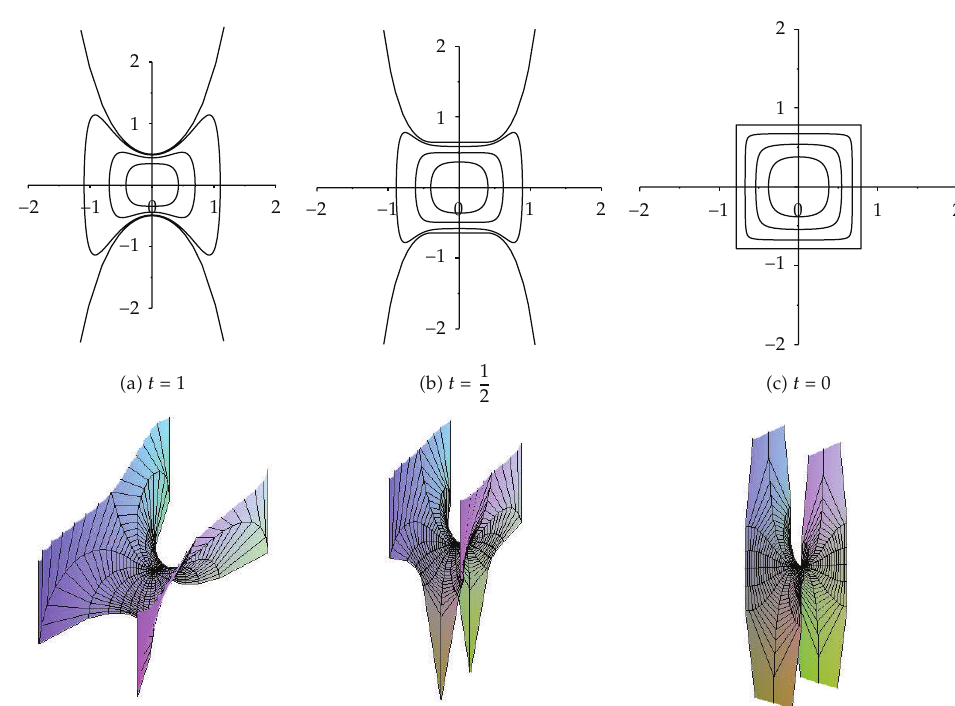
Figure 1: Images of concentric circles under f and corresponding minimal surfaces for various values of t in Example